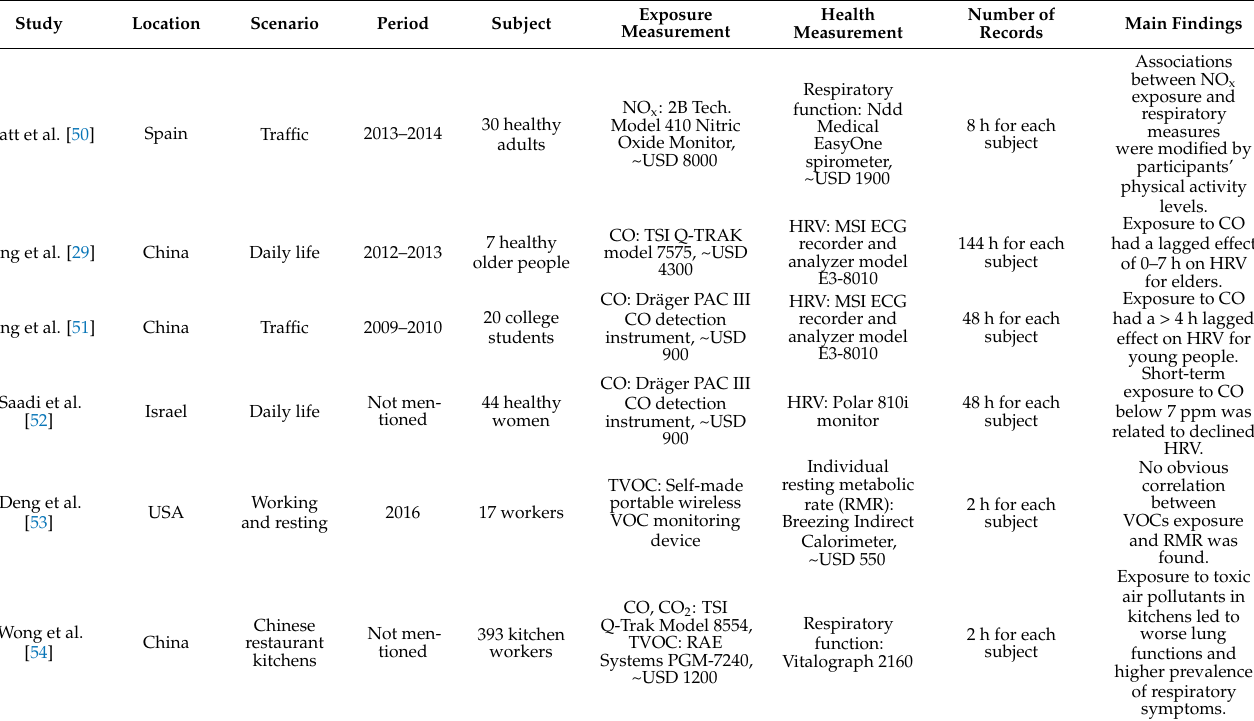
Table 2. Studies focusing on health effects of gaseous pollutant